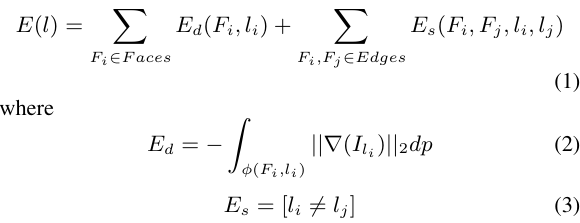
To this end, we apply the decimation algorithm of (Lindstrom and Turk, 1998, Lindstrom and Turk, 1999). The algorithm pro- ceeds in two stages. First, an initial collapse cost, given by the position chosen for the vertex that replaces it, is assigned to ev- ery edge in the reconstructed mesh. Then, at each iteration the edge with the lowest cost is selected for collapsing and replac- ing it with a vertex. Finally, the collapse cost of all the edges now incident on the replacement vertex is recalculated. For more tech- nical details, we refer the reader to (Lindstrom and Turk, 1998, Lindstrom and Turk, 1999).